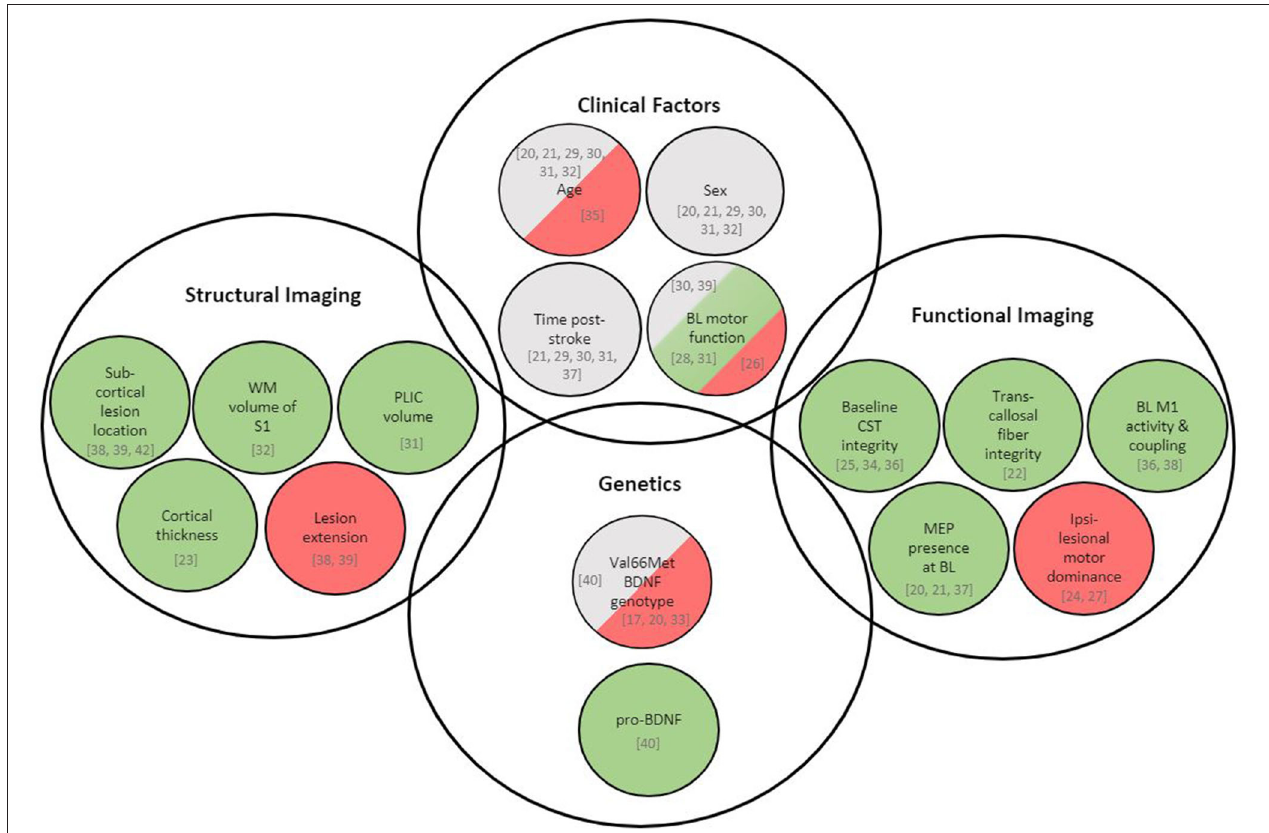
FIGURE 4 | Overview of variables associated with rTMS-induced recovery in stroke patients. Green represents variables being positively associated with rTMS response, red represents variables being negatively associated with rTMS response, and gray represents variables showing no association with rTMS response. Respective literature is specified in square brackets. BDNF , brain-derived neurotrophic factor; BOLD, blood oxygen level dependent; CST, corticospinal tract; MEP, motor-evoked potential; M1, primary motor cortex; PLIC, posterior limb of internal capsule; S1, primary somatosensory cortex; WM, white matter; BL,